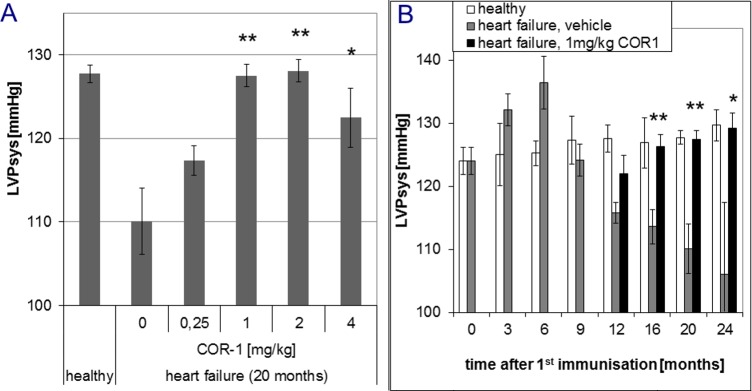
Effects of COR-1 on the left ventricular systolic pressure (LVPsys) of rats with HF induced by immunisation with GST-ß1EC2 fusion proteins.A: LVPsys of immunized rats after ten treatments(20 months after the first immunization), as determined by cardiac catheterization. Means of each group are shown with SEM for ß1EC2HF rats treated with vehicle (n = 5), 0.25 (n = 4), 1 (n = 10), 2 (n = 5), and 4 mg/kg BW COR-1 (n = 9), respectively. Mean LVPsys of healthy control animals are shown for comparison. *indicate statistical significance (p< 0.05) and **strong statistical significance (p<0.005), respectively, compared to the HF vehicle control group.The resulting ANOVA analyses showed overall significance, and post-hoc specific inter-group p values were 0.04 for HF + vehicle vs. healthy, and 0.002 for HF + 1 mg/kg COR-1 vs. HF + vehicle, 0.006 for HF + 2 mg/kg COR-1 vs. HF + vehicle, 0.0047 for HF + 4 mg/kg COR-1 vs. HF + vehicle. All other post-hoc analyses yielded non significant results. B: Time course of LVPsys, assessed every three months in healthy rats (white; n = 3 to 6) and ß1EC2HF rats treated 10 months after the first immunization-boostwith either vehicle (grey; n = 3 to 5) or with 1 mg/kg COR-1 (black;n = 4–10).Mean LVPsys with SEM are shown for all groups. *(p<0.05) and **(p<0.005) indicate statistical significance compared to the HF vehicle group. Analysis of variance (ANOVA) revealed no differences at baseline, but significant worsening of LVPsys in the immunized HF rats compared to healthy control rats, starting 12 months after the first immunisation. HF rats treated with 1 mg/kg COR-1 differed significantly from the HF vehicle group, but did not significantly differ from healthy control rats at 16, 20, and 24 months.